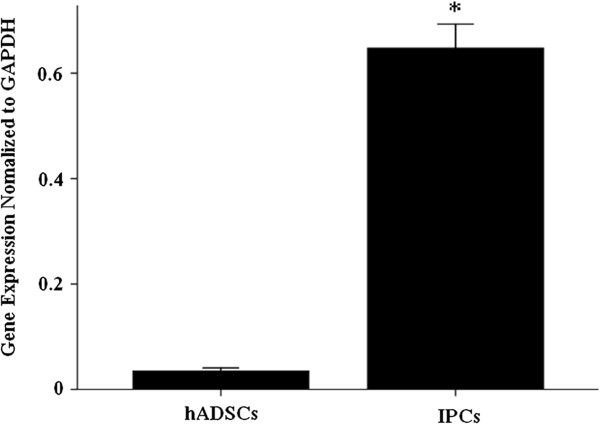
Gene expression analysis. Insulin gene expression by two groups of cells was 0.04 ± 0.004 for hADSCs and 0.65 ± 0.036 for IPCs; cycle threshold values of PCR assay were 14.12 ± 0.45 and 14.33 ± 0.37, respectively. Gene expression was normalized to GAPDH. The asterisk denotes P < 0.05.